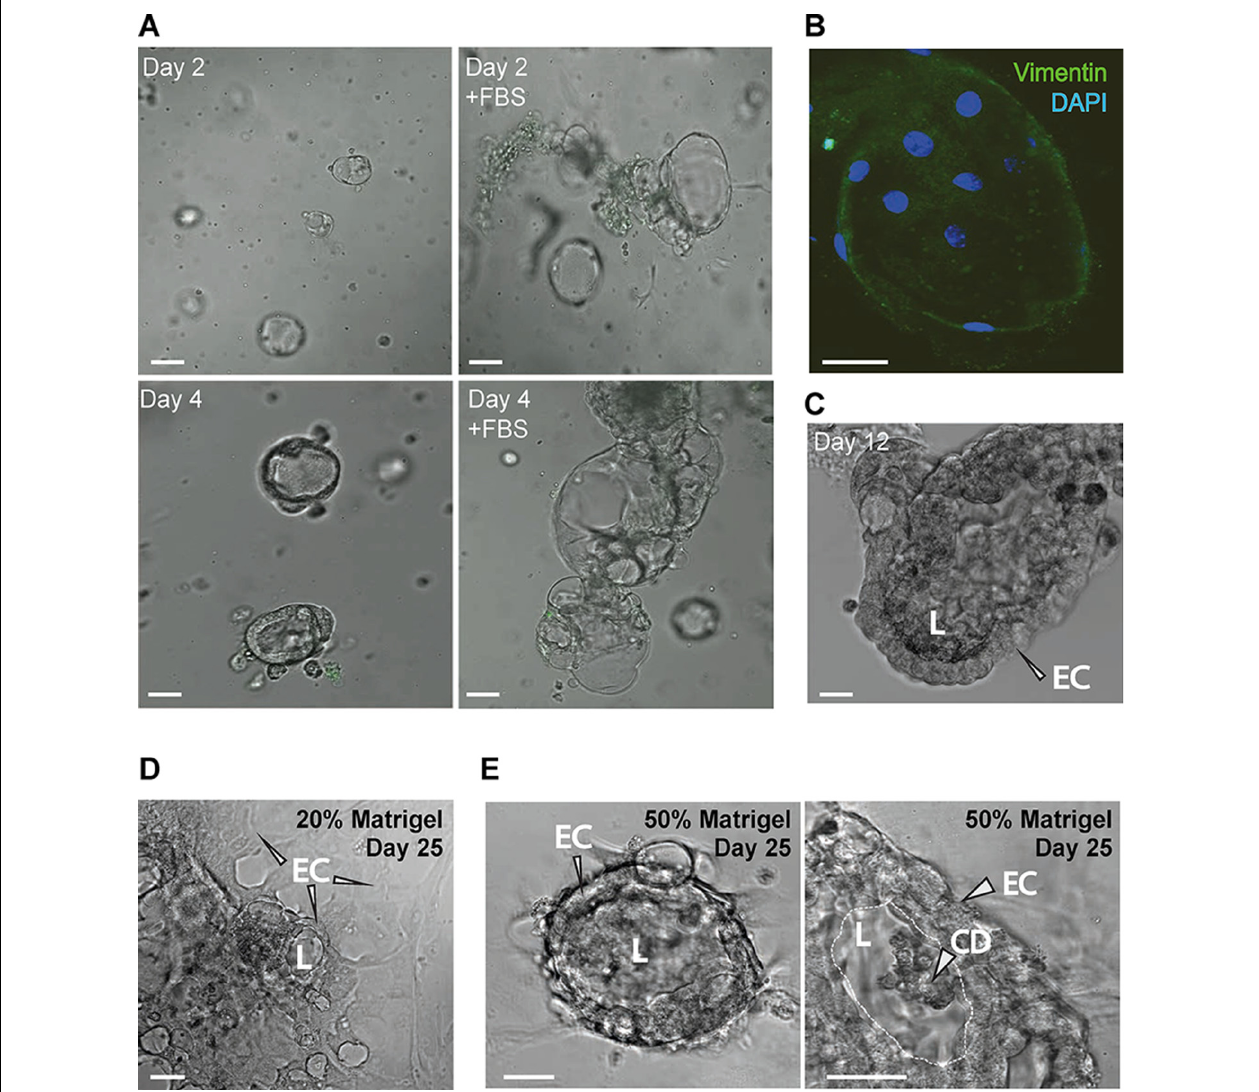
FIGURE 5 | (A) The addition of FBS increases the CP explant growth (bar 20 µ m). (B) Ara-C-treated CP explants show very few fibroblasts labeled by vimentin immunostaining (bar 10 µ m). (C) CP ex cultured for 12 days. FBS was withdrawn during the last 3 days. (D,E) CP explants plated in 20% and 50% Matrigel on day 25. Panel to the right shows a magnified view of the epithelial cells (ECs), lumen (L) and accumulation of cell debris (CD) in the lumen (bar 20 µ m).